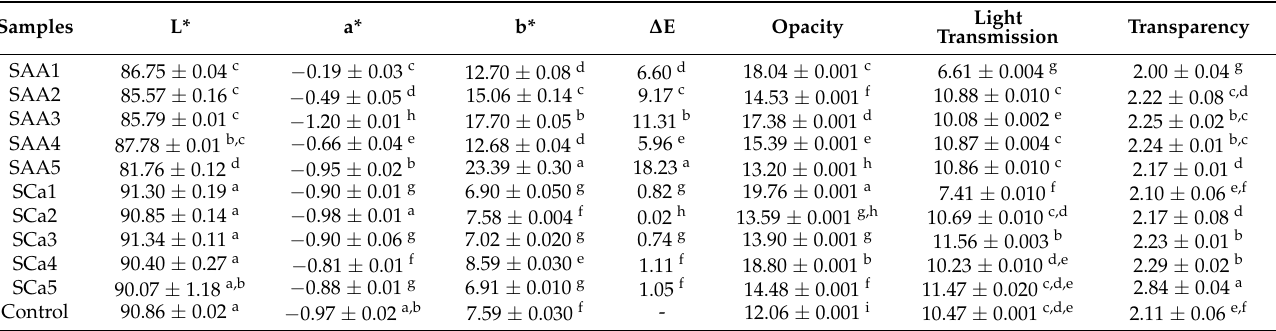
Table 3. Variation in the optical properties of the membranes with different additions of AA and CaCl 2